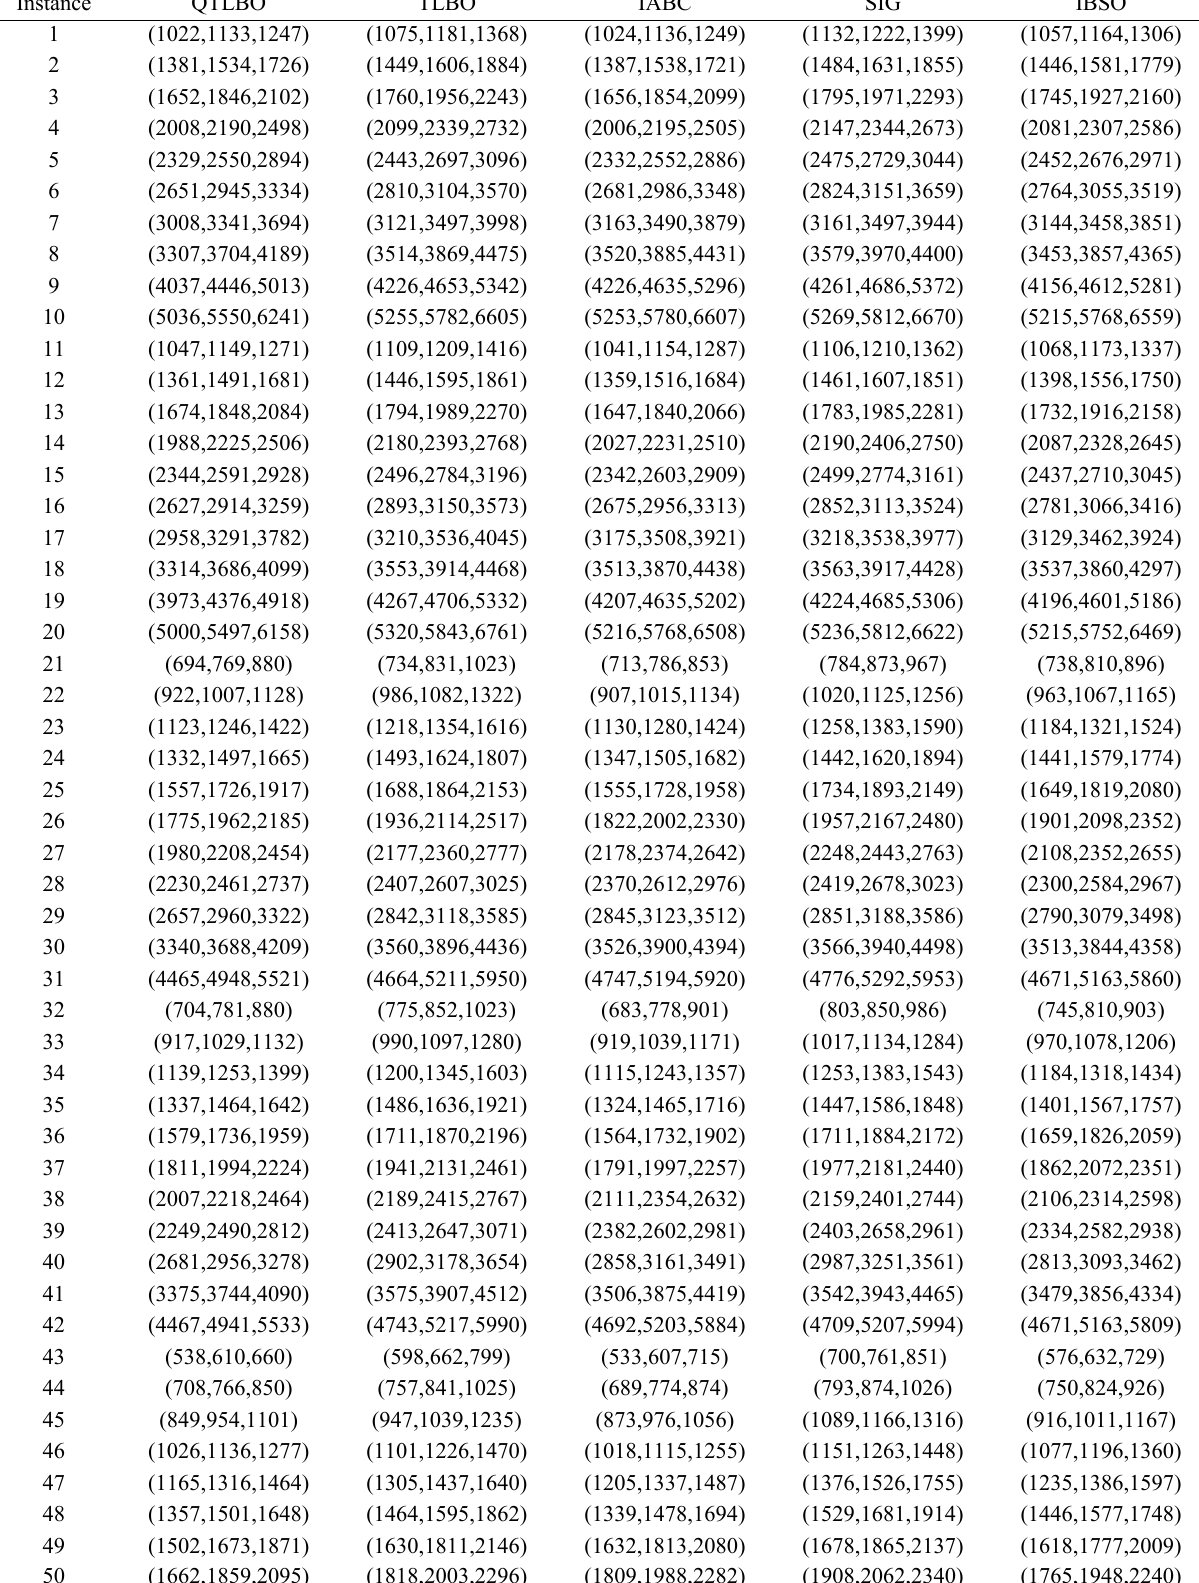
Max Table 9 Computational results of all algorithms on for instances